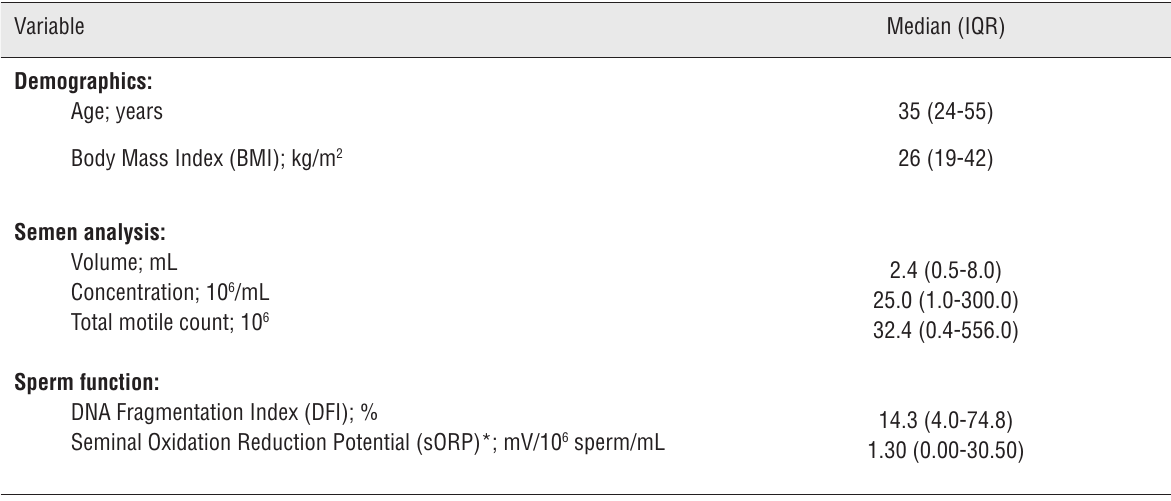
Table 2 - Baseline data of 86 infertile men included in the correlation analysis between sperm DNA fragmentation index (DFI) and seminal static oxidation reduction potential (sORP).